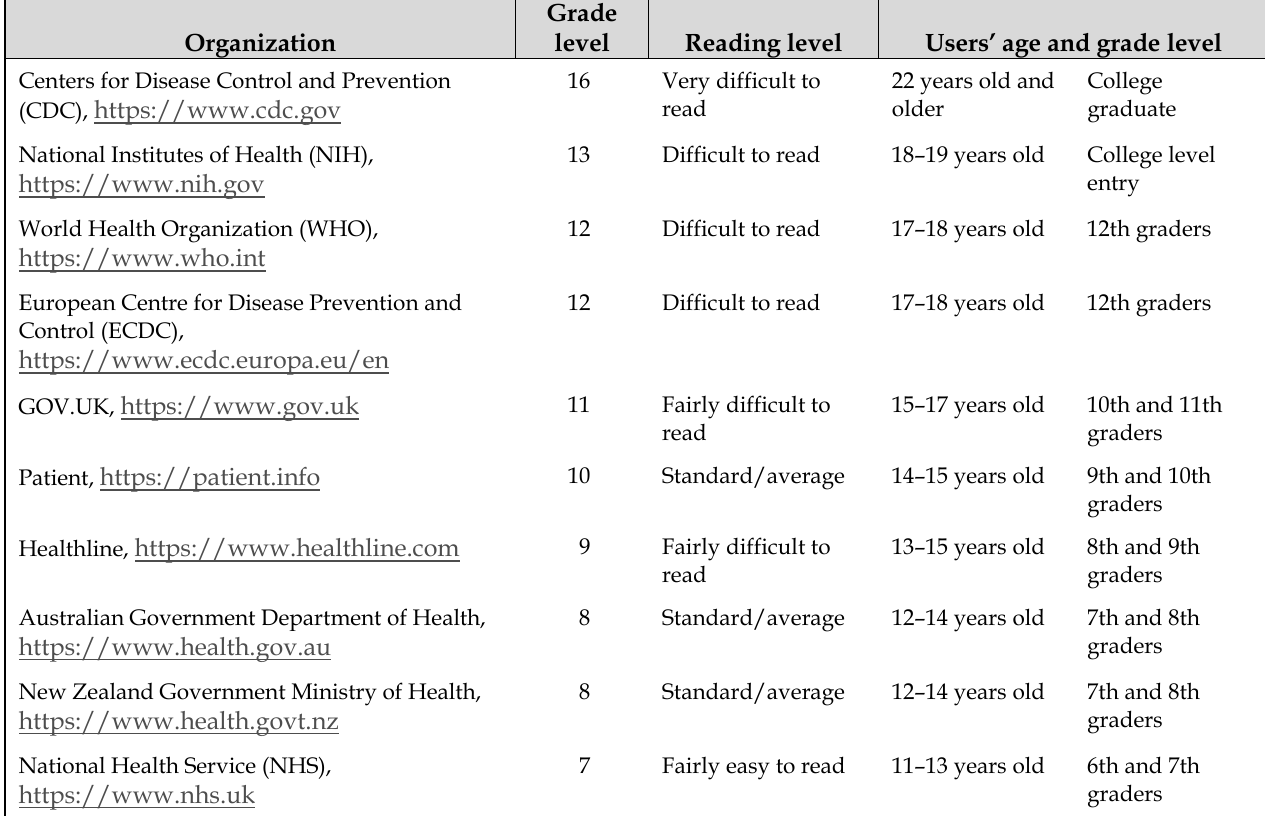
Table 5 Readability levels for websites published by prominent international and national organizations Grade Organization level Reading